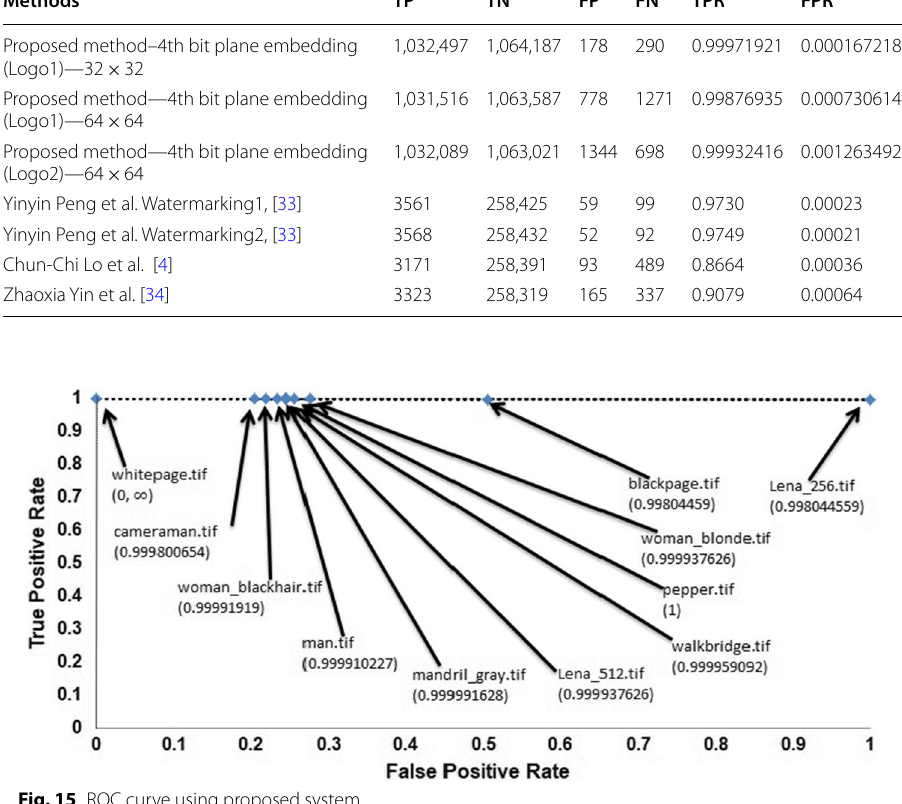
Fig. 15 ROC curve using proposed